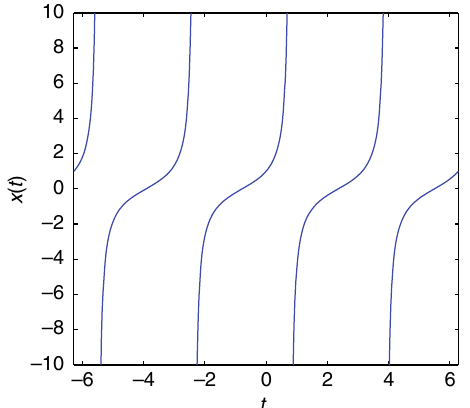
Fig. 6 Analytical solution of the 1D quadratic integrate-and- fi re neuronal model given by Eq. (52) for I